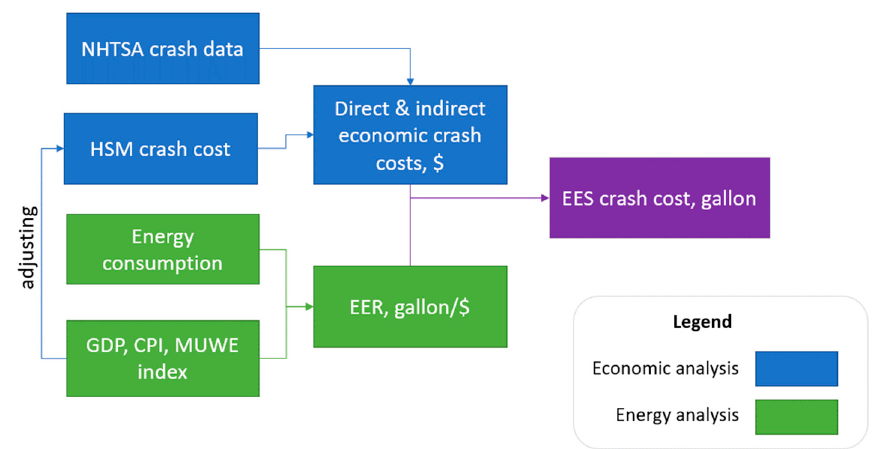
Figure 4. Energy equivalence flowchart. Note: NHTSA, National Highway Traffic Safety Administration; HSM, Highway Safety Manual; CPI, Consumer Price Index; MUWE, median